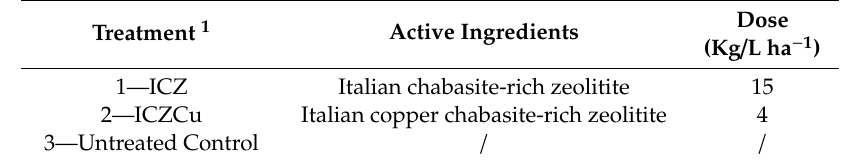
Table 1. Field application details towards grey mould and sour rot on cv. Trebbiano d’Abruzzo in Controguerra vineyard in 2018 and